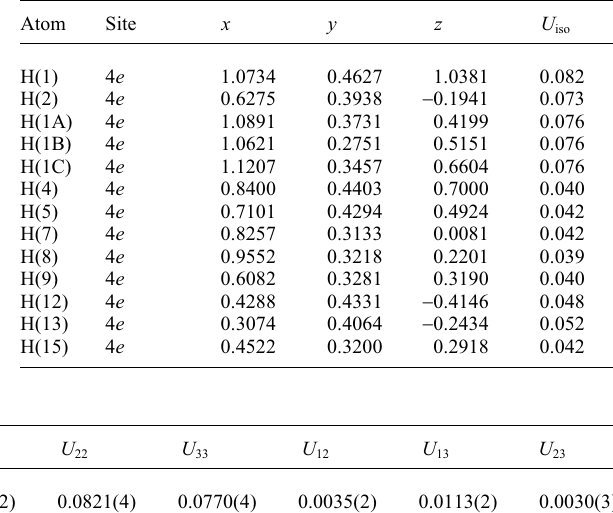
Table 2. Atomic coordinates and displacement parameters (in Å 2 ) .